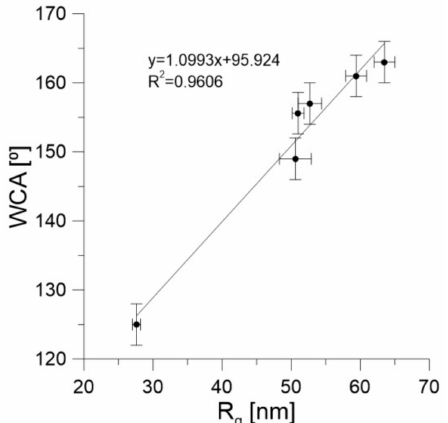
Figure 5. WCA dependence on the Rq, together with the results of fitting to the straight line. Note that for Rq close to zero the WCA was ca. 96 ◦